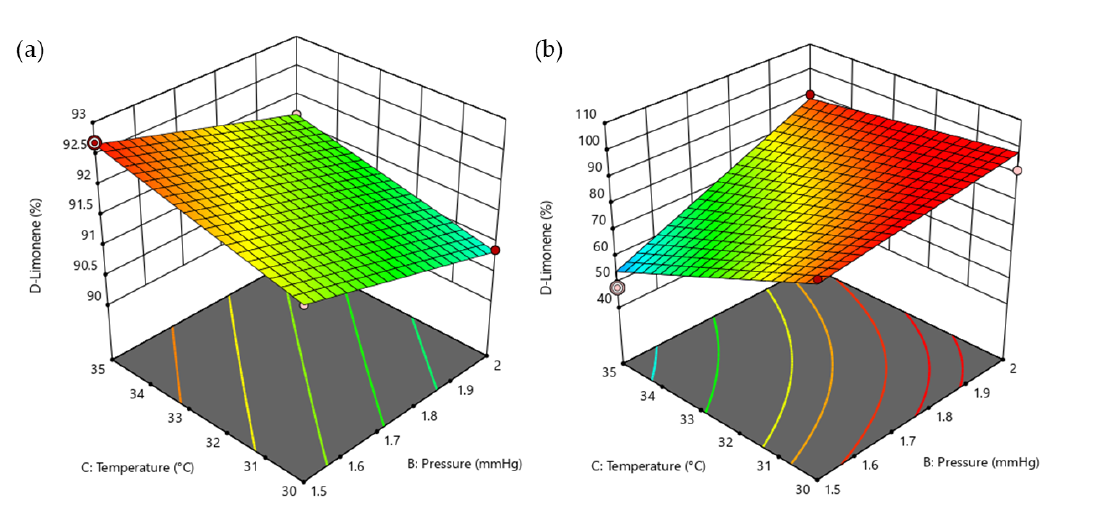
Figure 3. Response-surface representations in molecular distillation. ( a ) Percentage of D-Limonene in distillate and ( b ) percentage of D-Limonene in residue.